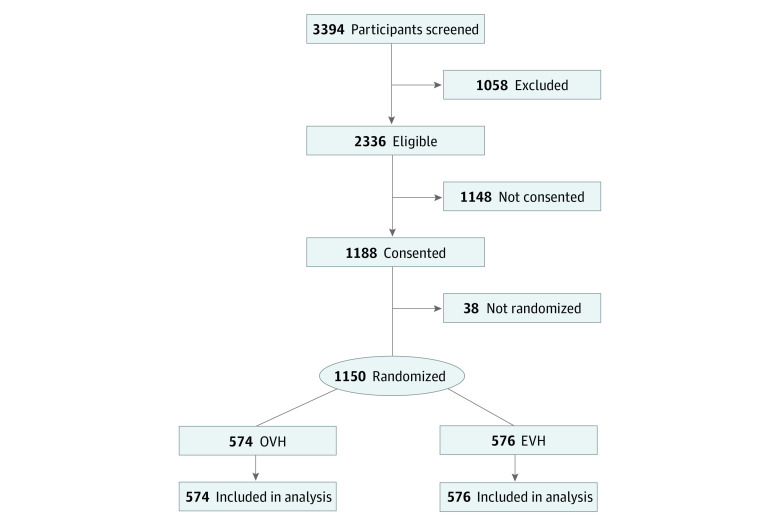
Participant Enrollment and Randomization FlowchartOne ineligible participant was mistakenly considered eligible and was consented and randomized.